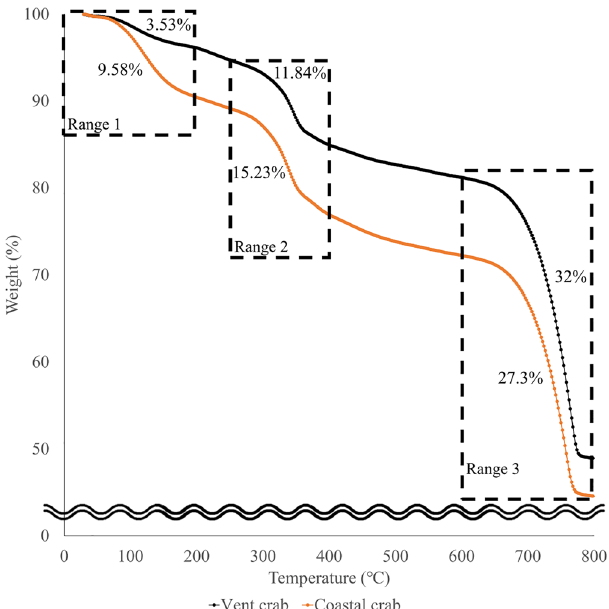
Figure 3. Thermogravimetric analysis (TGA) curve. The first stage of weight loss was visible from room temperature to 200 °C, which indicates the removal of water or volatile components. The second weight loss (250–500 °C) indicates that chitin or organic matter has been removed. The third weight loss (600–800 °C) indicates that calcium carbonate, an inorganic component that forms the exoskeleton, has been